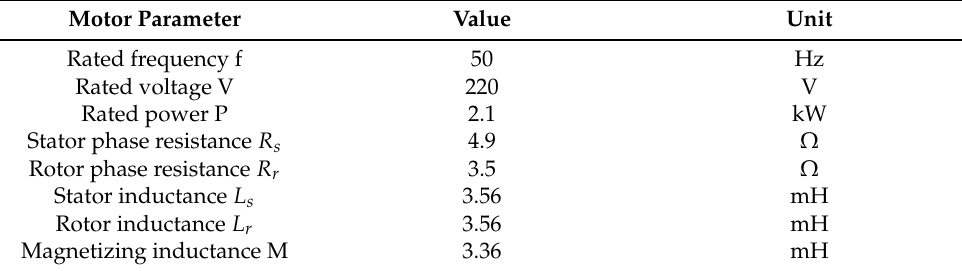
Table 1. Diagnostic indexes at constant speed—experimental